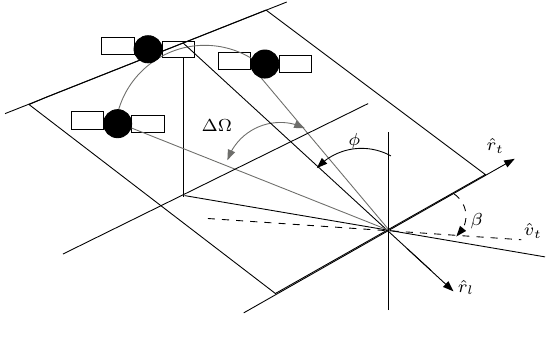
Figure 5. ISAR imaging geometry of